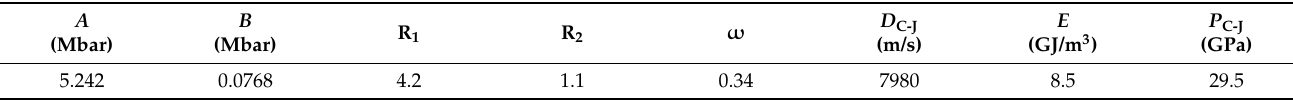
Table 4. Material parameters of B explosive.